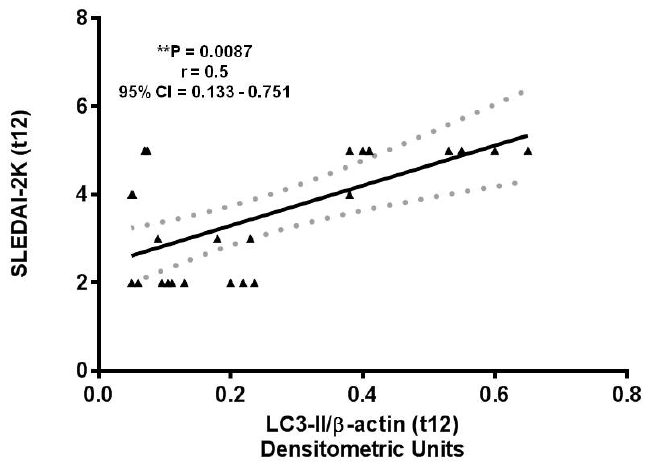
Figure 2. Correlation between LC3-II autophagy marker levels determined by western blotting and clinical parameters. Correlation and linear regression analysis of LC3-II expression levels in lysates from 26 patients with SLE and SLE Disease Activity Index 2000 (SLEDAI-2K) scores after 12 weeks (t12) of belimumab administration:** p = 0.0087, r = 0.5, 95% confidence interval (CI) = 0.133 −